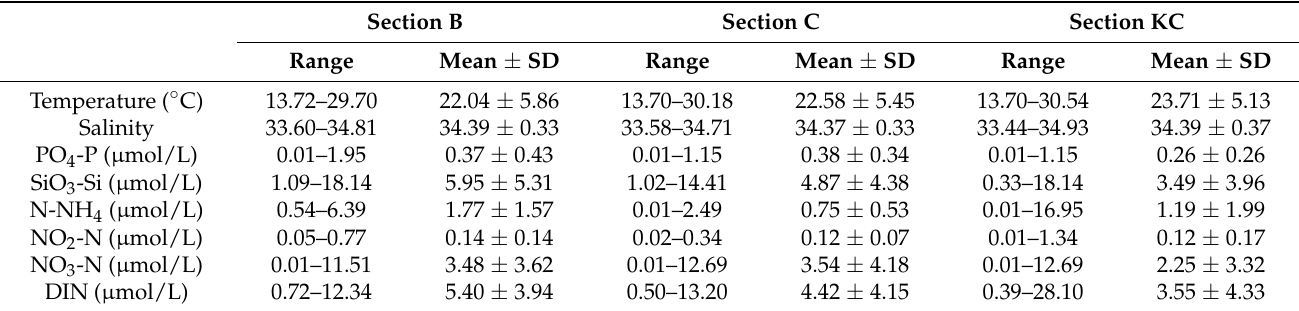
Table 1. Range and mean ± SD of environmental variables in three contrasting sections.